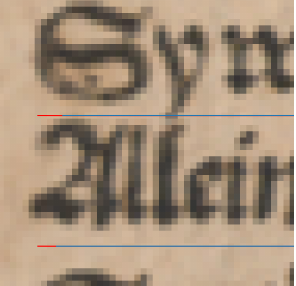
Figure 6. Example of baselines being extended. Baselines as predicted by the network are drawn in blue, and the extended baseline is drawn in